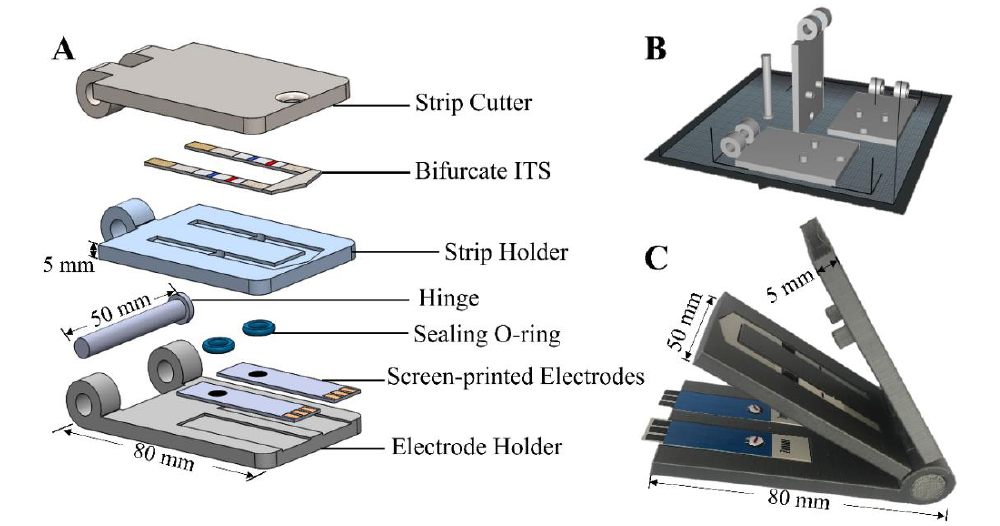
Figure 6. Prototype of the nanomaterial-enhanced multiplexed electrochemical immunosensing sys- tem (NEMEIS) device, an electrochemical immunosensing platform. Exploded view of the accessories ( A ), isometric 3D drawings from the top, side, and front viewpoint of the strip cutter manufactured by 3D printing ( B ), 3D view of assembled device, including strip cutter, strip holder with integrated strips, and electrode holder with screen-printed electrodes ( C ). Reproduced with permission from Ruan et al. [36], Biosensors and Bioelectronics, 184, 113238. Published by Elsevier,